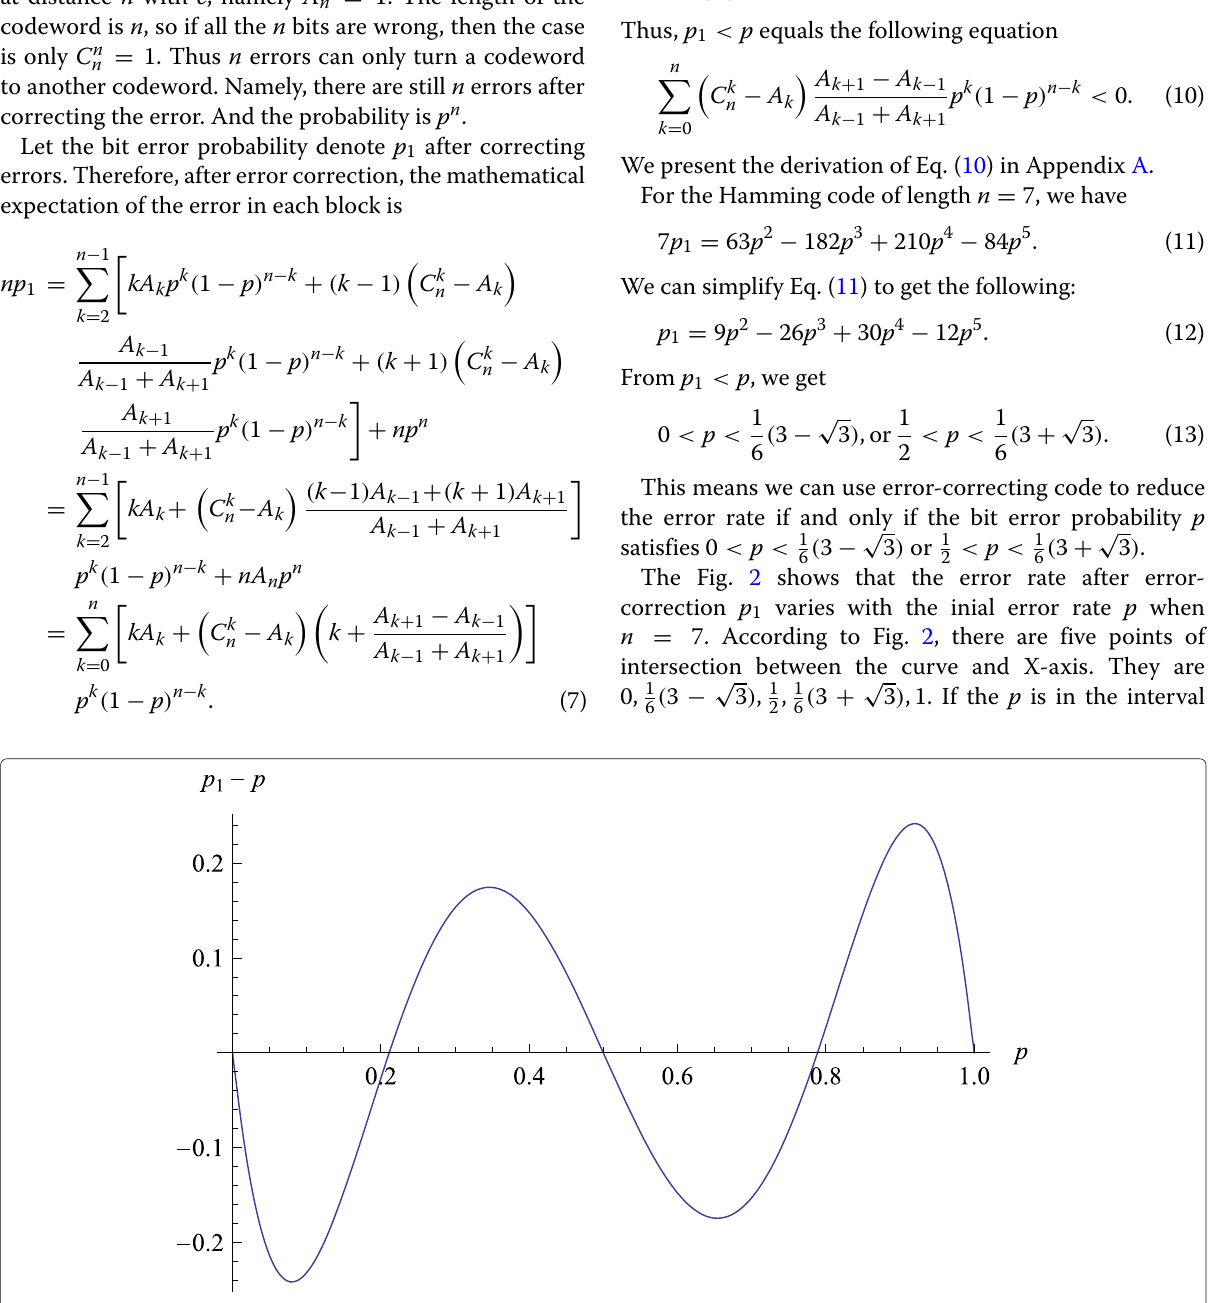
Fig. 2 The error rate after error-correction p 1 varies with the inial error rate p when n =